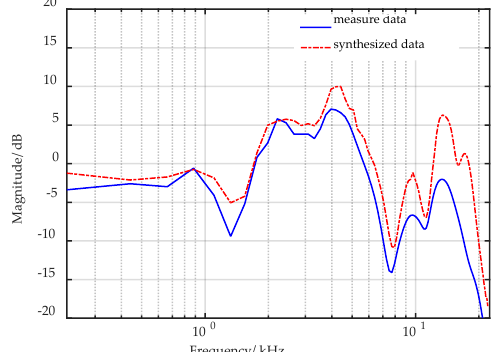
Figure 7. The comparison of measure data and synthesized data for KEMAR dummy head at same direction. The solid line in blue represents the measured data of HRTF, and the broken line in red represent the synthesized data of HRTF, respectively.